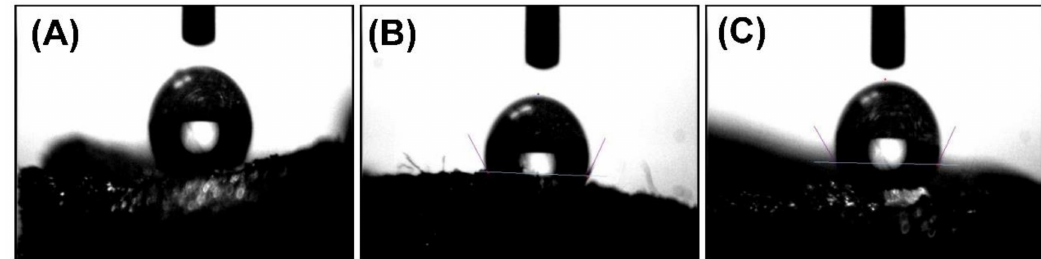
Figure 3. Photos for measuring the contact angle of cryogels against water ( A : C-63p2, B : C-65p2, C :